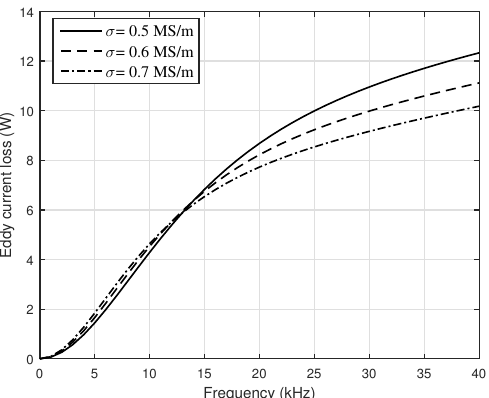
Figure 6. Magnet eddy current losses vs. frequency for sintered NdFeB classes (same isotropic relative permeability of 1.05 assumed).